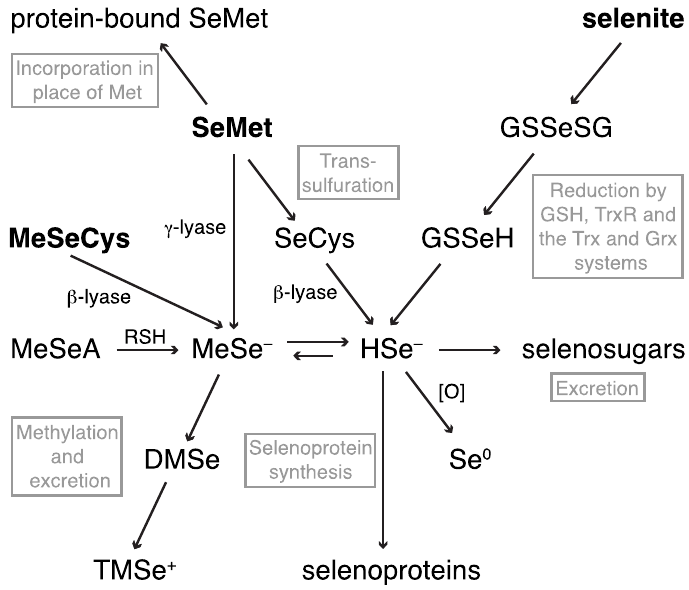
Figure 2. An overview of the metabolism of the dietary selenium compounds selenite, SeMet and MeSeCys. See text for